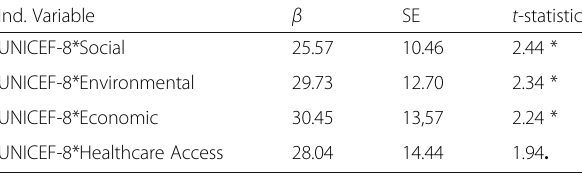
Table 6 Rank Ordering Classes of